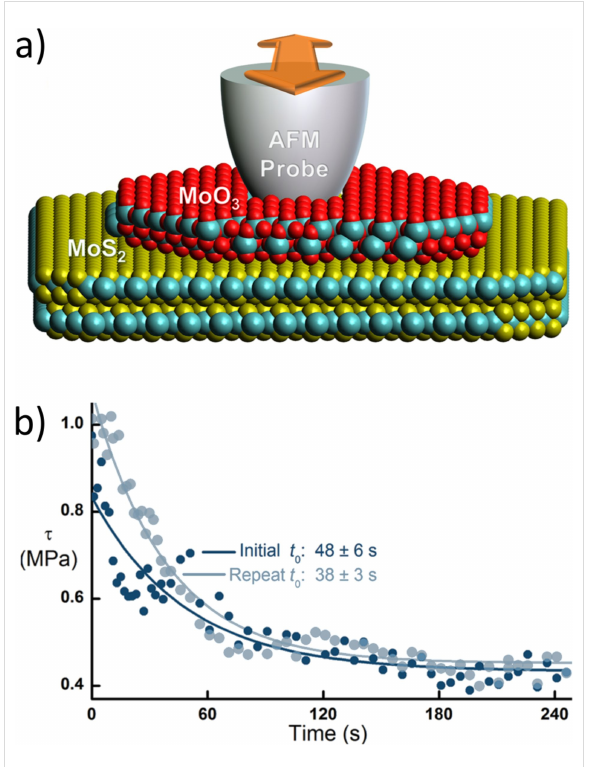
Figure 1: a) Scheme of a MoO 3 nanocrystal on MoS 2 . The AFM tip is firmly positioned on top on the nanocrystal and can facilitate continu- ous manipulation of the structure. b) Friction of the MoO 3 nanostruc- ture as a function of the time obtained by continuous recording of fric- tion loops. The initial friction decreases with time (as described by the time constants) until a stationary friction level is reached. This effect can be attributed to thermolubricity related to the friction-driven tem- perature increase at the interface. Reprinted with permission from [65], copyright 2017 American Chemical